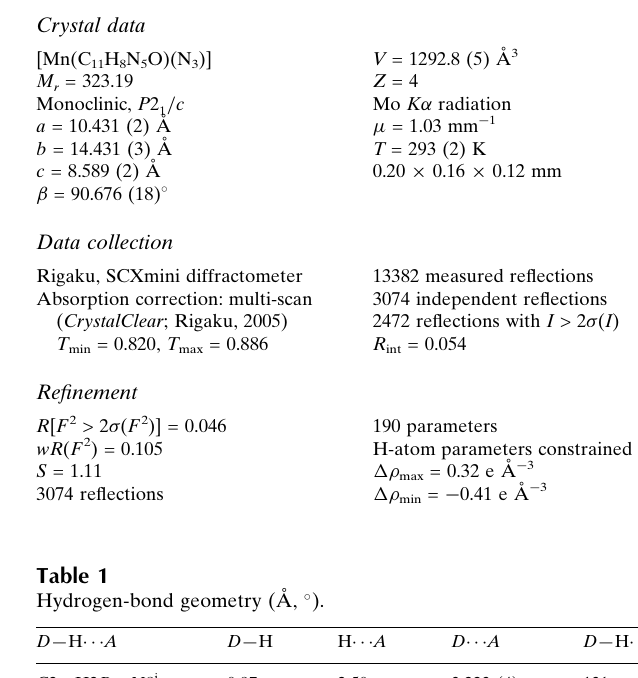
Rigaku, SCXmini diffractometer Absorption correction: multi-scan